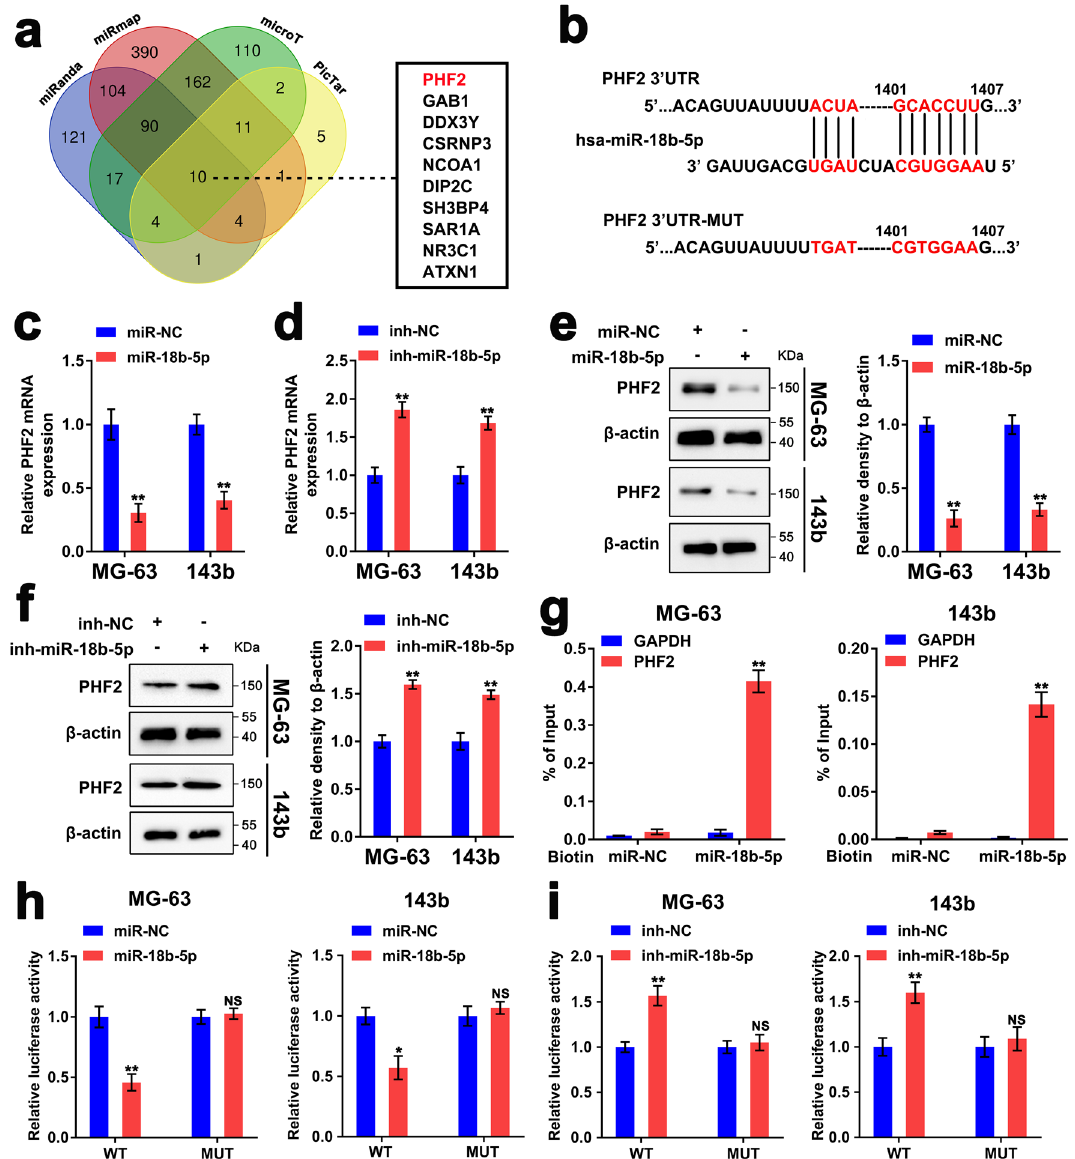
Figure 3. miR-18b-5p modulates the expression of PHF2 through post-transcriptional regulation. ( a ) Venn diagram showed the predicted targets of miR-18b-5p from databases (miRanda, miRmap, microT and PicTar). The image was created using Online tools of Bioinformatics Evolutionary Genomics (http:// bioin forma tics. psb. ugent. be/ webto ols/ Venn/). ( b ) Schematic diagram showed the predicted interaction between 3 ′ -UTR- PHF2- mRNA and miR-18b-5p. The mutated sequences of the 3 ′ -UTR-PHF2- mRNA was displayed. ( c , d ) RT-qPCR assay showed the expression of PHF2 mRNA in MG-63/143b cells with miR-18b-5p overexpression or inhibition. ( e , f ) Western blotting assay showed the protein level of PHF2 in miR-18b-5p upregulated or downregulated MG-63 and 143b cells. ( g ) Biotin-based pulldown assay detected the enrichment of PHF2 on biotinylated miR-NC and miR-18b-5p probe with the mRNA of GAPDH acted as control. ( h , i ) The luciferase reporter assay accessed luciferase activity of miR-18b-5p upregulated or downregulated MG-63 and 143b cells transfected with luciferase reporter plasmid carrying WT-3 ′ -UTR-PHF2 or MUT-3 ′